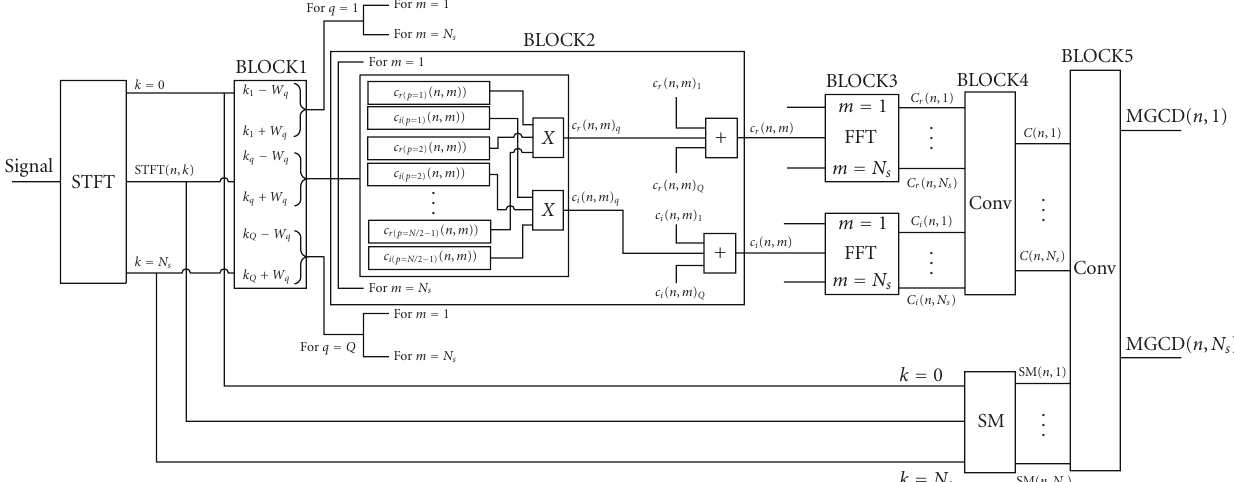
Figure 1: Parallel architecture for realization of generalized complex-lag distribution for multicomponent signals.